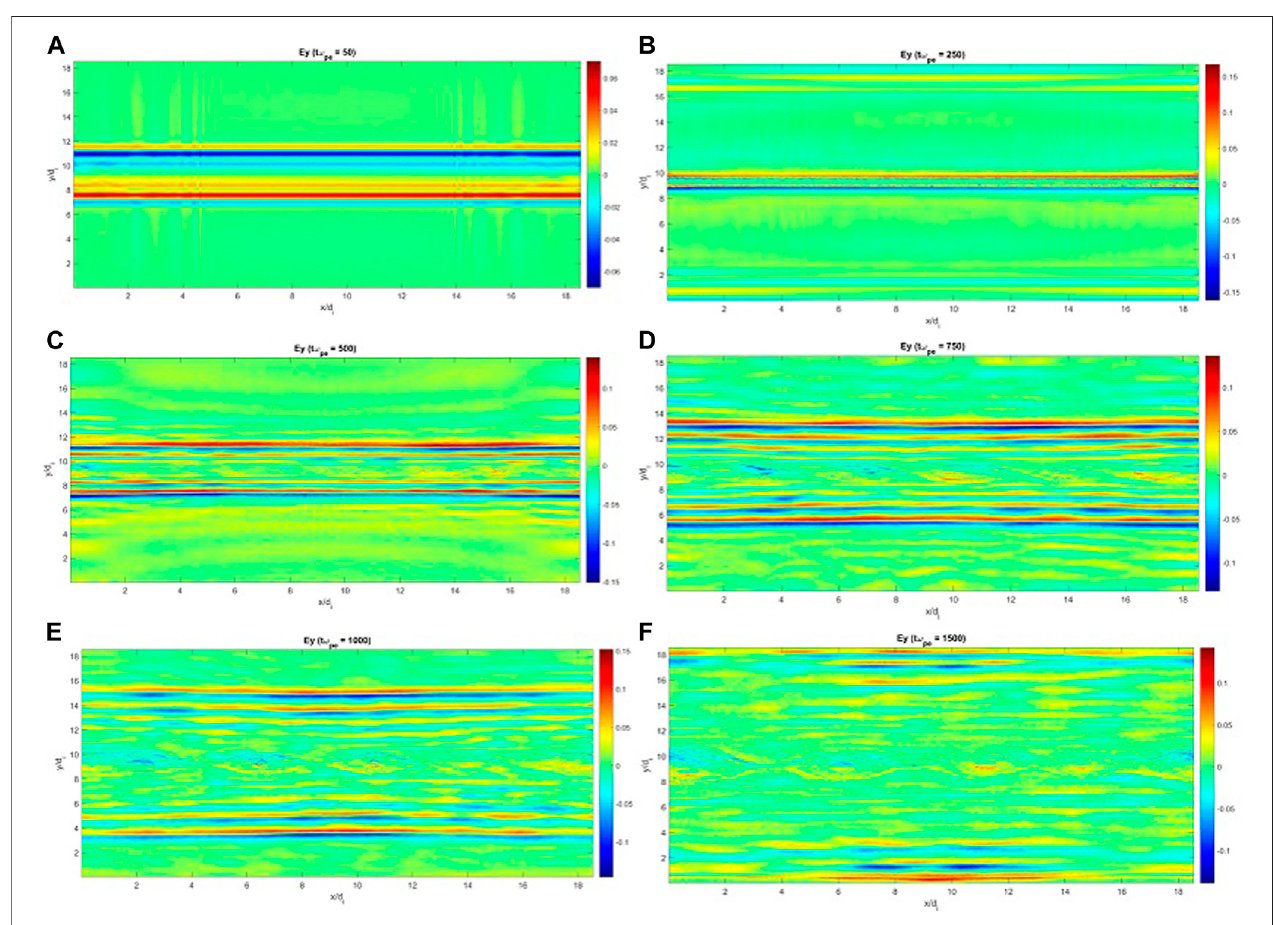
FIGURE 3 | E y component of the electric fi eld at times: t ω pe (cid:1) 50 (A) , 250 (B) , 500 (C) . 750 (D) , 1,000 (E) , 1,500 (F) with b z 0 (cid:1) 0.3 B 0 .